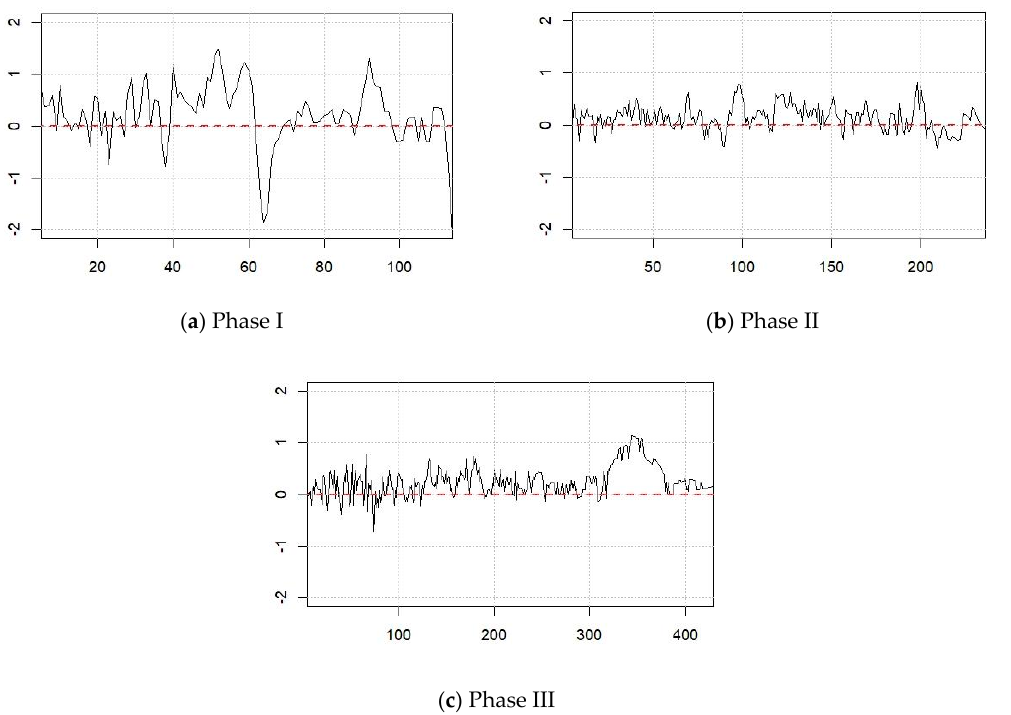
Figure 4. Excess asymmetry in multifractality ( ∆ F 2 ) . ( a ) ∆ F 2 of Phase I; ( b ) ∆ F 2 of Phase II; ( c ) ∆ F 2 of Phase III.